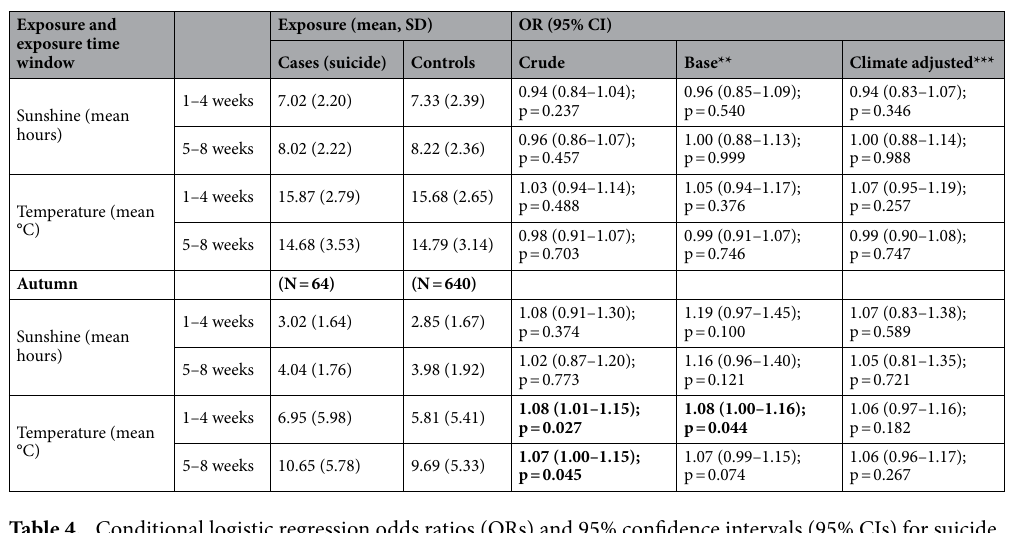
Table 4. Conditional logistic regression odds ratios (ORs) and 95% confidence intervals (95% CIs) for suicide associated with sunshine hours and temperature during two exposure windows, by sex, age and season when the antidepressant treatment was started. Statistically significant results are given in bold. **Adjusted for previous suicide attempt, county, sex, age, year and season when the antidepressant treatment was initiated. ***Adjusted for all variables in Base model and temperature when sunshine was the exposure variable or sunshine when temperature was the exposure